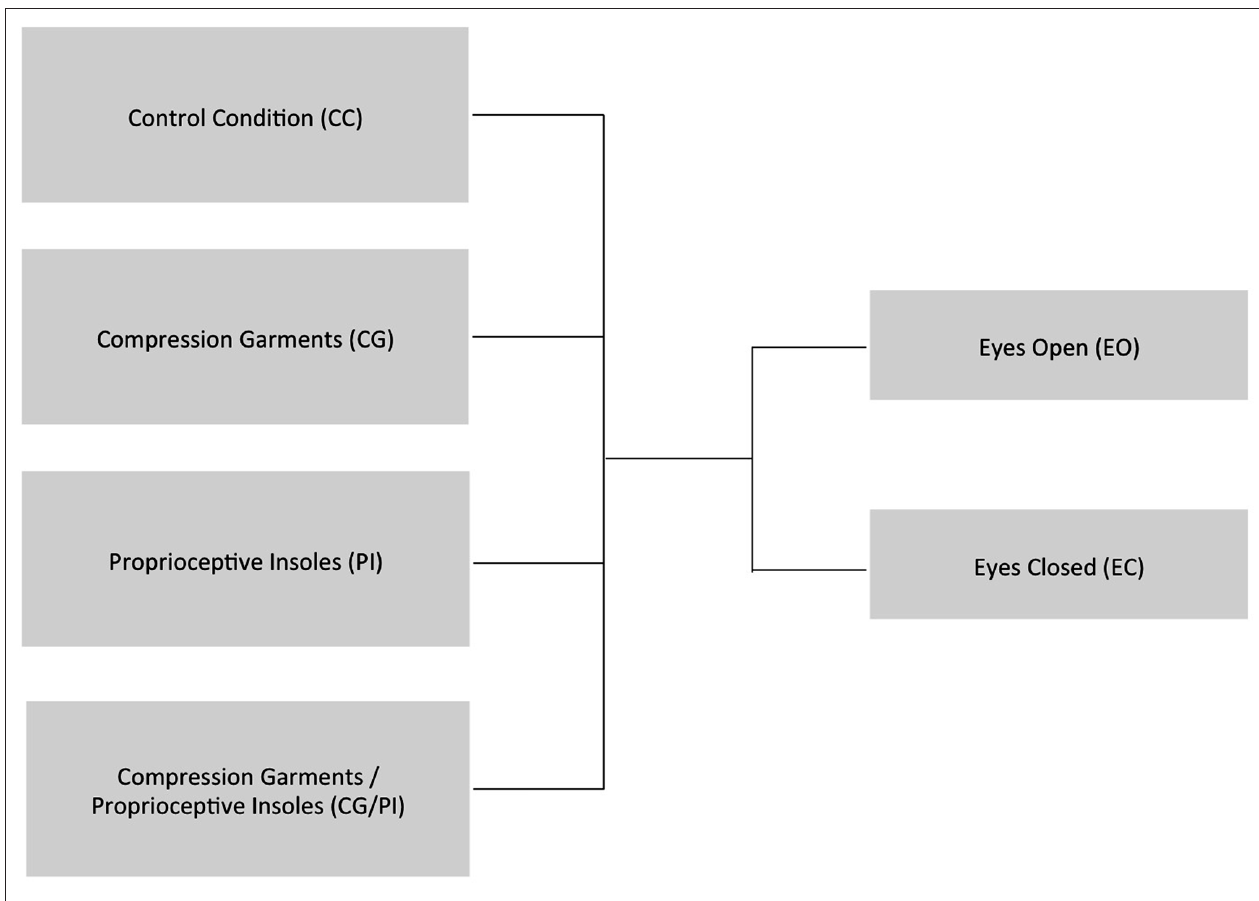
FIGURE 2 | Design of the postural control